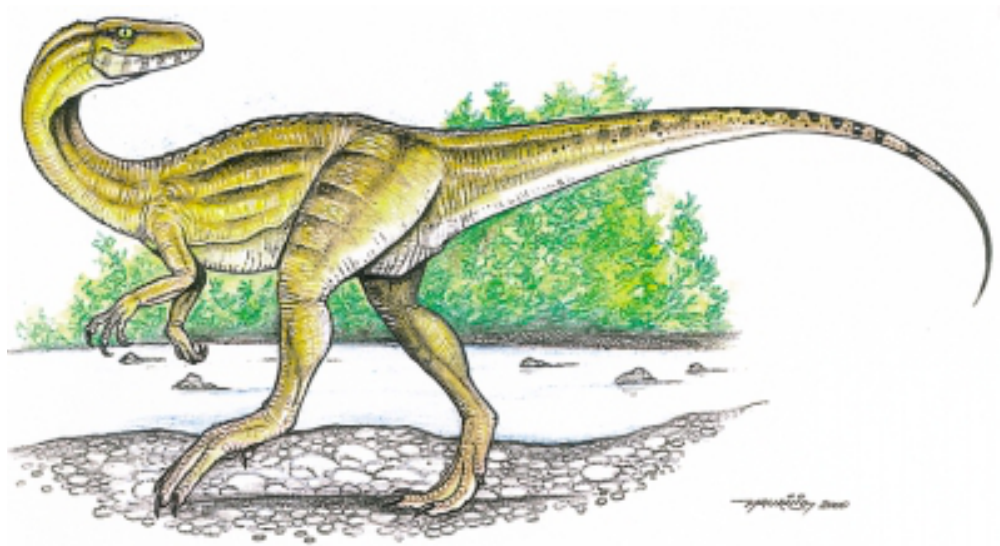
Fig. 14 – Reconstruction of Staurikosaurus pricei , a primitive theropod from the Santa Maria Formation (Triassic).